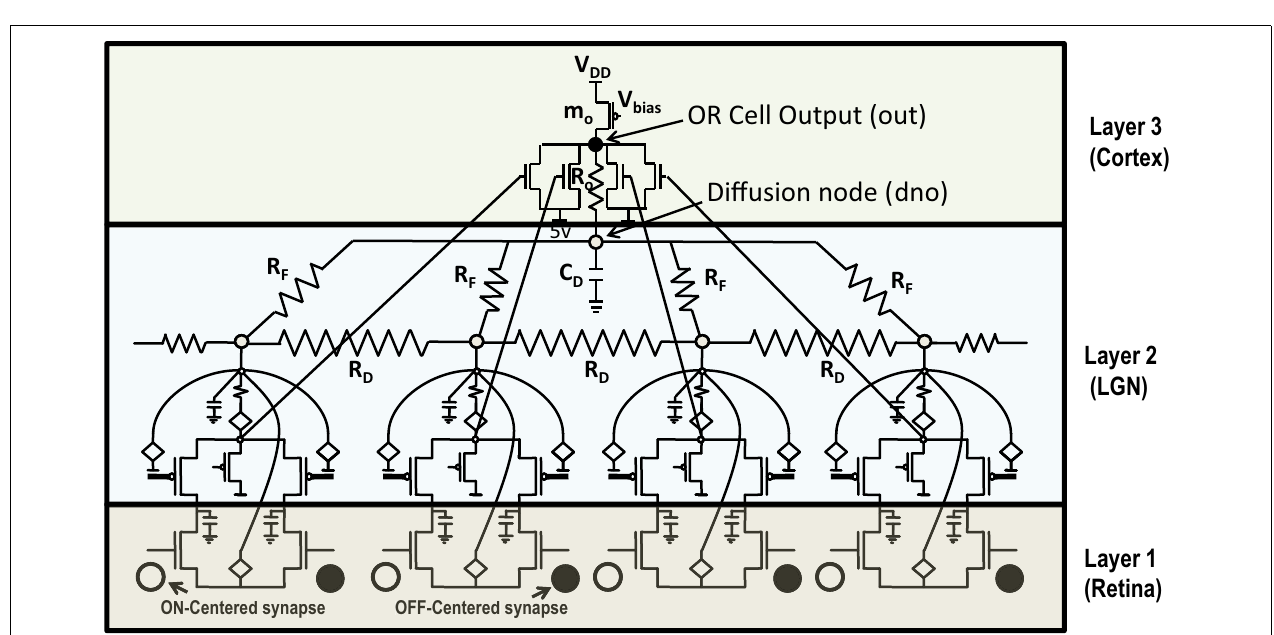
innervate at a single cortical cell forming its receptive field. (B) Shows the elongated ON-Centered, OFF-Surround receptive field of a cortical cell (Inspired by Hubel and Wiesel’s model of Orientation Selectivity). (C) Shows the elongated OFF-Centered, ON-Surround receptive field of a cortical cell.